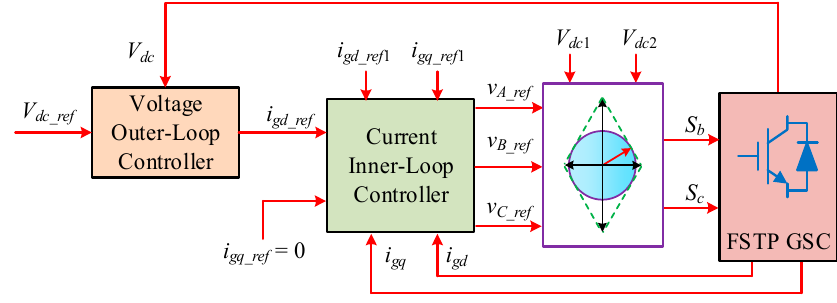
Figure 8. Dual control loop structure for FSTP GSC.